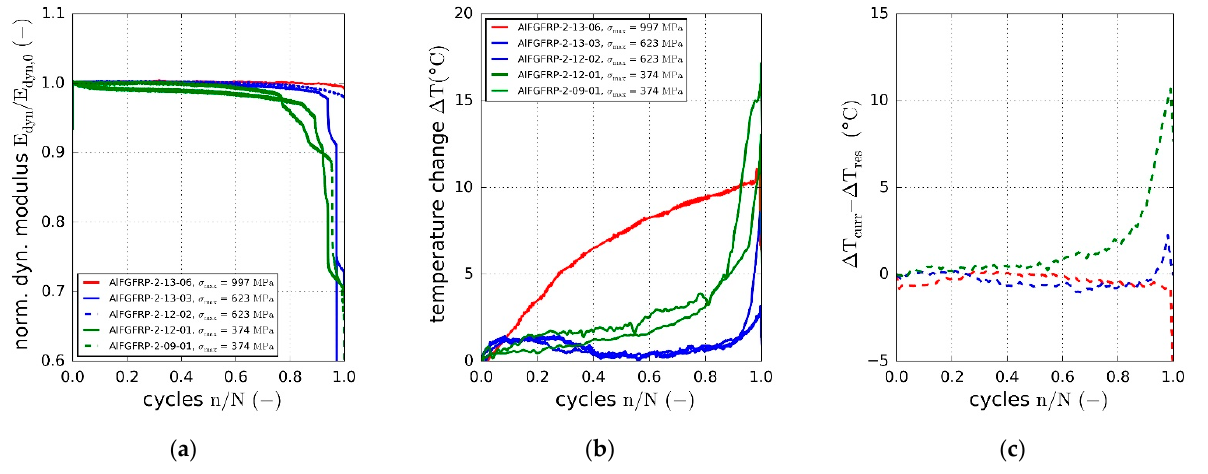
Figure 26. Test results of the combined electric and mechanical fatigue load testing: dynamic stiffness ( a ), surface temperature changes ( b ) and temperature differences between the electrically loaded and unloaded specimens ( c ).